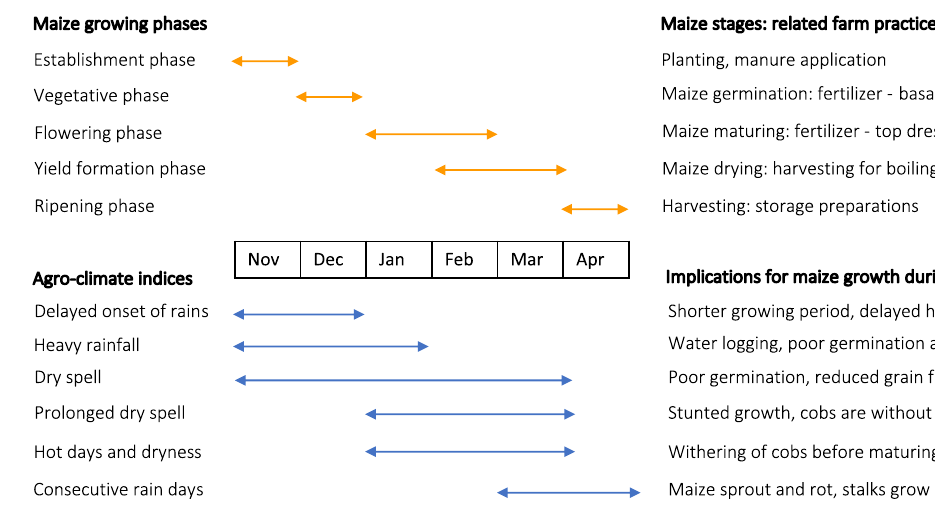
FIGURE 2 | Linkages between different phenological stages of maize growth and farm practices during November to April rainy season, and identified maize-specific agro-climate indices and their implications on maize growth and yield.